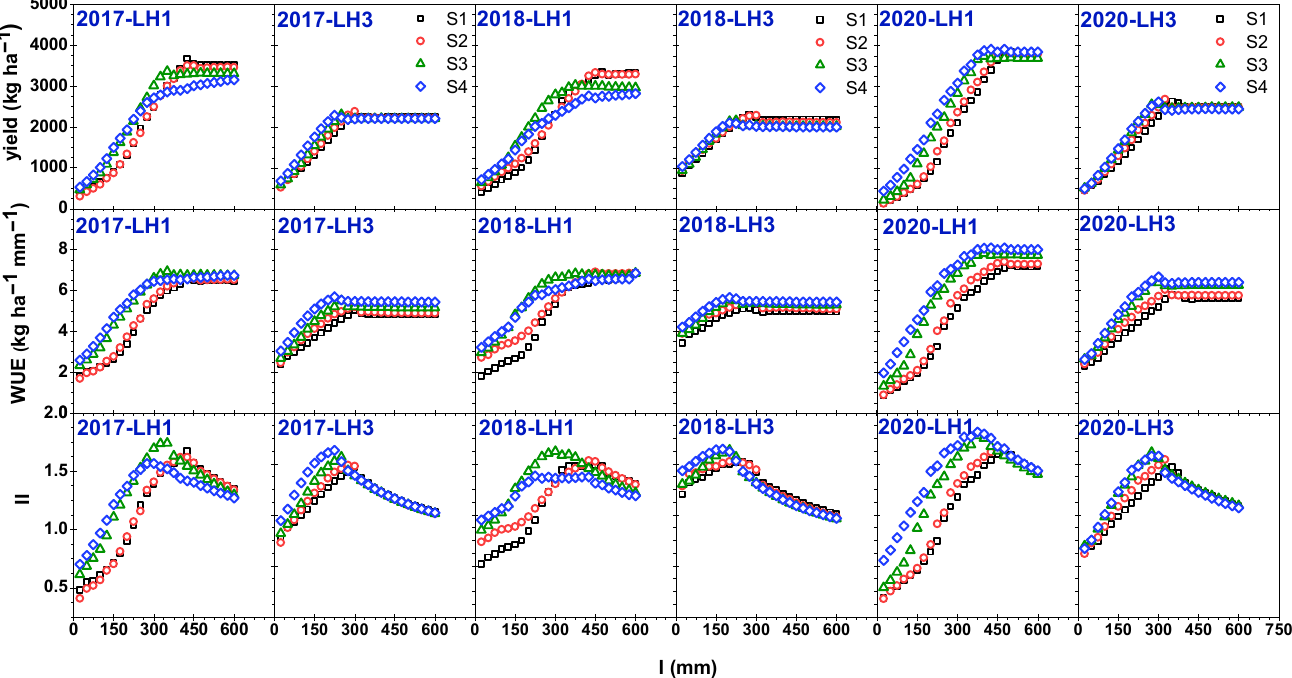
Figure 6. Comparison of the four plans and two varieties of soybean yield, water use efficiency (WUE), integrated index (II) in 2017, 2018 and 2020.